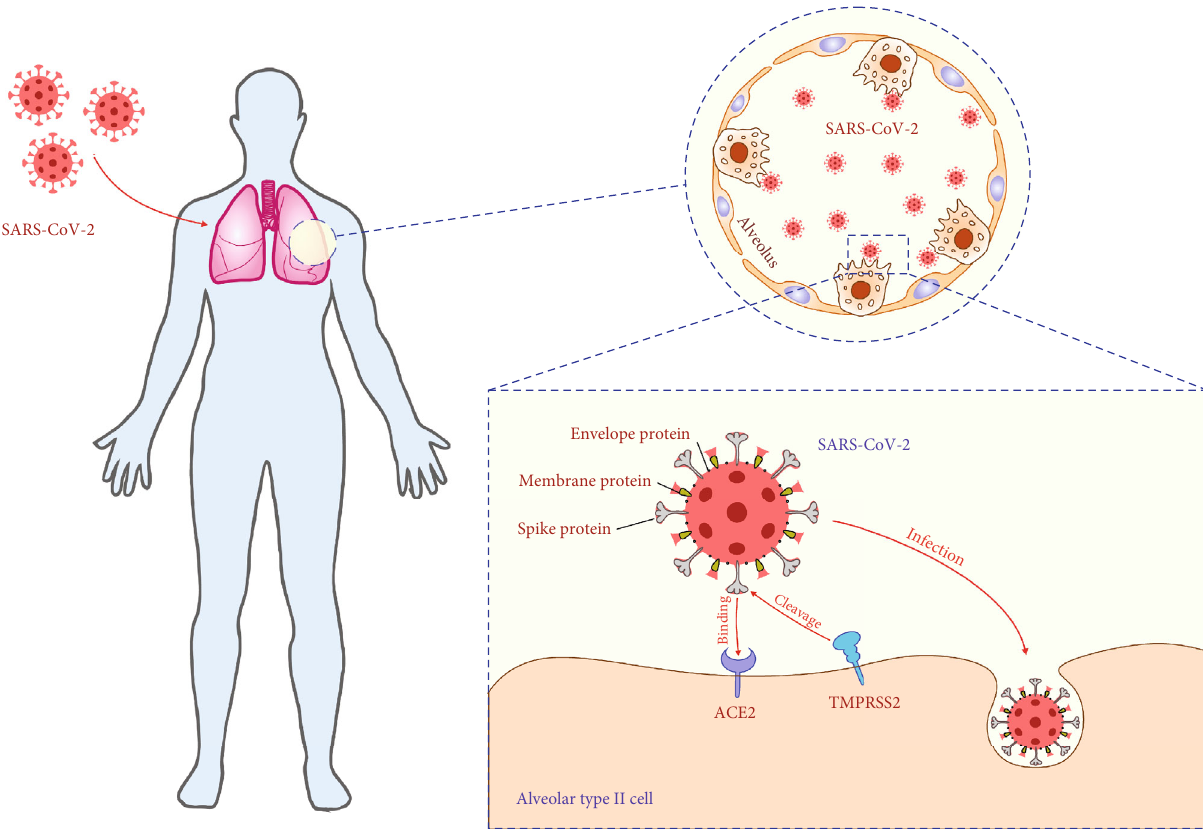
Figure 1: Cellular entry of SARS-CoV-2. Envelope, membrane, and spike proteins form the SARS-CoV-2 protein interface to the external environment. After inhalation, aerosols containing SARS-CoV-2 penetrate the depths of the lungs and cause severe pneumonia, alveolar injury, and acute respiratory distress syndrome (ARDS). The initial step in the development of SARS-CoV-2-induced ARDS is the interactions between the SARS-CoV-2 spike protein and angiotensin-converting enzyme 2 (ACE2) and transmembrane protease serine 2 (TMPRSS2) of alveolar type II cells. TMPRSS2 splits the spike protein into two functional subunits, S1 which interacts with ACE2 and S2 that is further cleaved and activated by TMPRSS2. This structural and conformational change in the spike protein facilitates fusion of viral envelope with the cell membrane of AT2 cells, enabling endocytic entry of the virus in the target